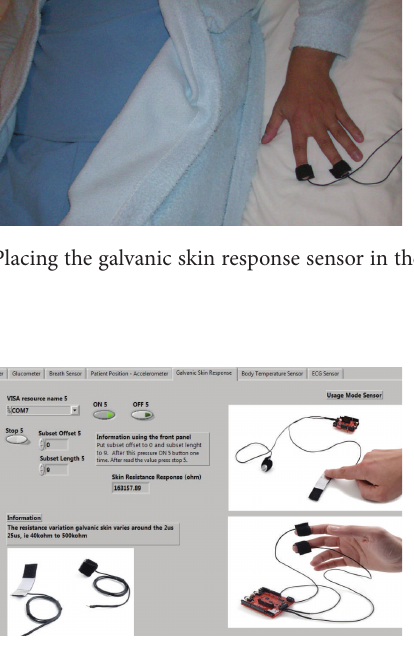
Figure 19: Obtaining the value of the galvanic skin response in the MCT [14].